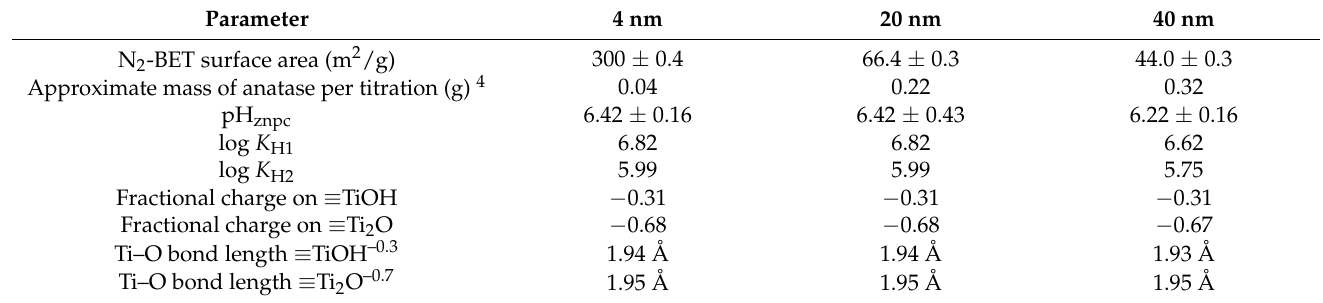
Table 1. Physical characteristics, experimental pH znpc values, MUSIC model parameters 1 , and predicted protonation constants 2 for the three anatase samples 3